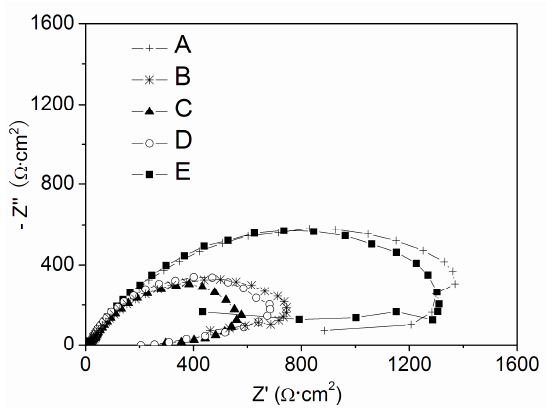
Figure 12. The Nyquist plots in 0.10 mol/L NaCl solutions at the E OCP of X70 carbon steel electrodes after 10 min anodic polarization at 0.500 V in α mol/L Na 3 PO 4 + β mol/L NaNO 2 solutions (A) α = 0.040, β = 0; (B) α = 0.030, β = 0.010; (C) α = 0.020, β = 0.020; (D) α = 0.010, β = 0.030; (E) α = 0, β = 0.040.